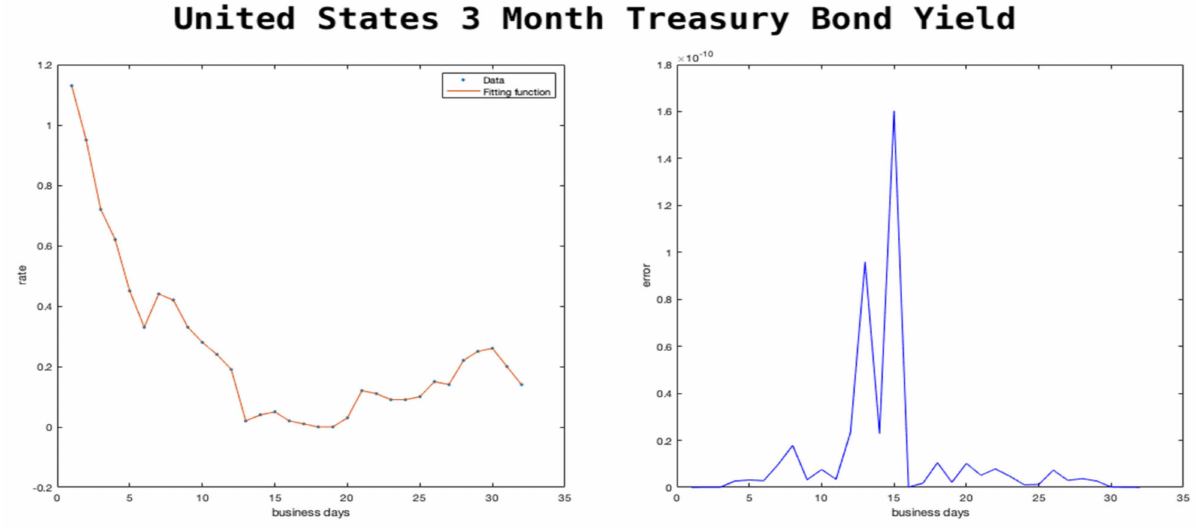
Figure 3. Fitting function of 3-month treasury bond rate from 1 March 2020 to 15 April 2020. N = 48, error range is [0, 1.6031 × 10 − 10